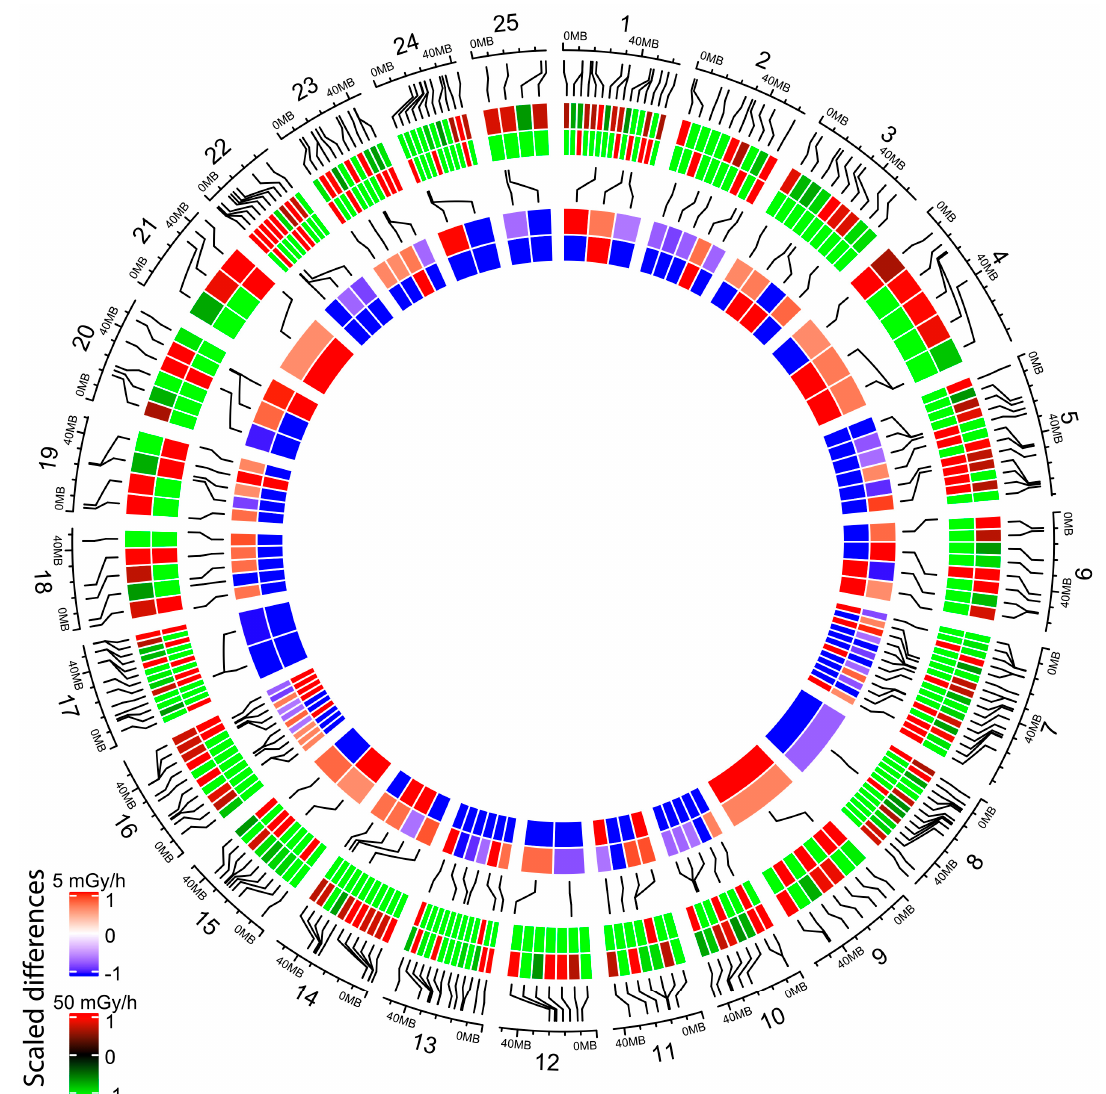
Figure 6. Circos plot of differentially methylated promoter associated with DEG at 50 mGy/h (two outer circles) and 5 mGy/h (two inner circles). Zebrafish chromosome number are indicated from 1 to 25 and approximate genomic locations are displayed by black lines. Promoter methylation changes (defined as DMR located at < 3 kb from TSS, % methylation difference ≥ 10% and permutation p -value < 0.05) and gene expression changes (fold change of DEG with adjusted p -value < 0.05) were normalised on the same scale to visualise effect of promoter methylation on gene expression. Outer circle: % methylation difference in DMR at 50 mGy/h (hypermethylation: red, no change: white and hypomethylation: green). Second circle: DEG at 50 mGy/h (upregulation: red, no change: white and downregulation: green). Third circle: % methylation difference in DMR at 5 mGy/h (hypermethylation: red, no change: white and hypomethylation: blue). Inner circle: DEG at 5 mGy/h (upregulation: red, no change: white and downregulation: blue).